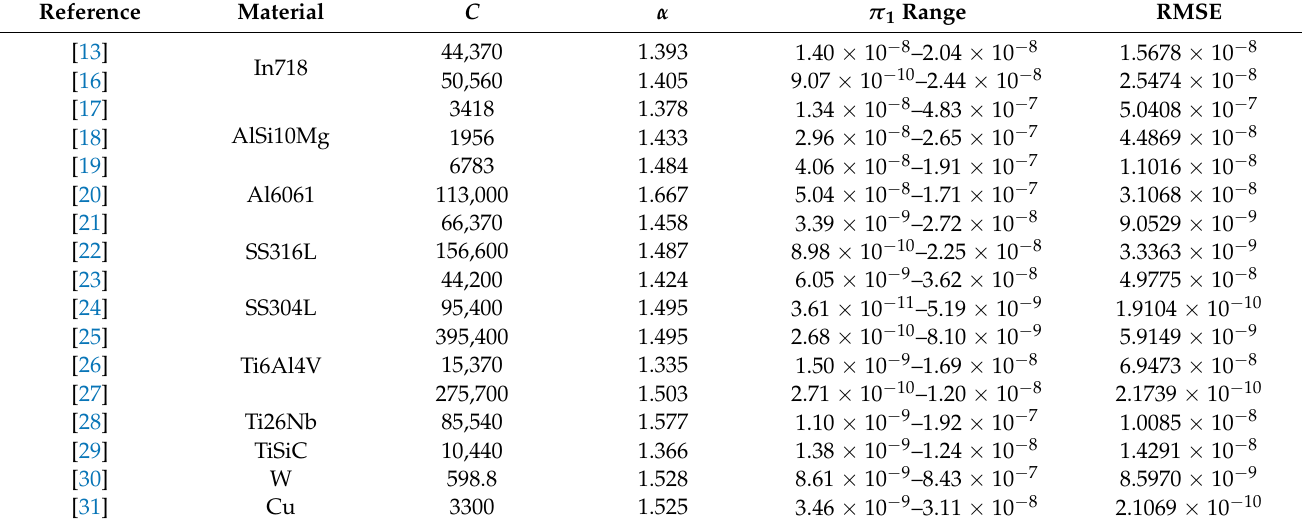
Table 2. C and α fitting parameters values, calculated with method one, in the respective independent dimensionless product range π 1 of